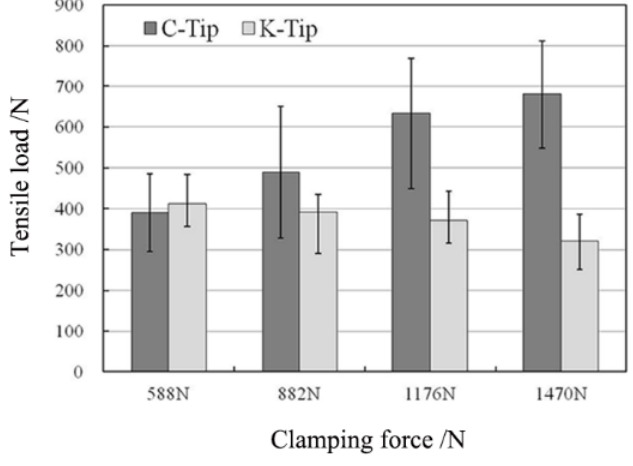
Figure 22. Joint strength using C-tip and K-tip at 1.0 s welding time [49].